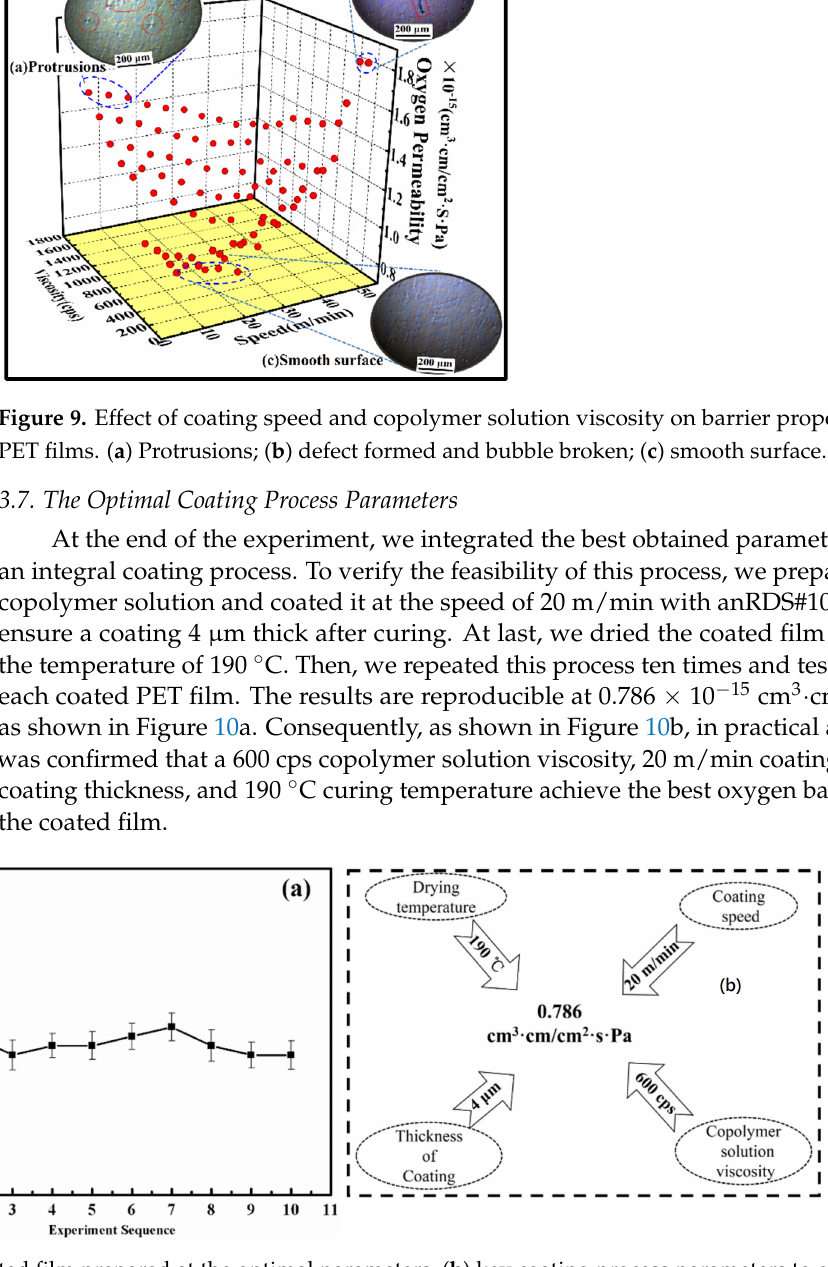
Figure 10. ( a ) P o 2 of the coated film prepared at the optimal parameters, ( b ) key coating process parameters to obtain best barrier performance of coated film in practical application.